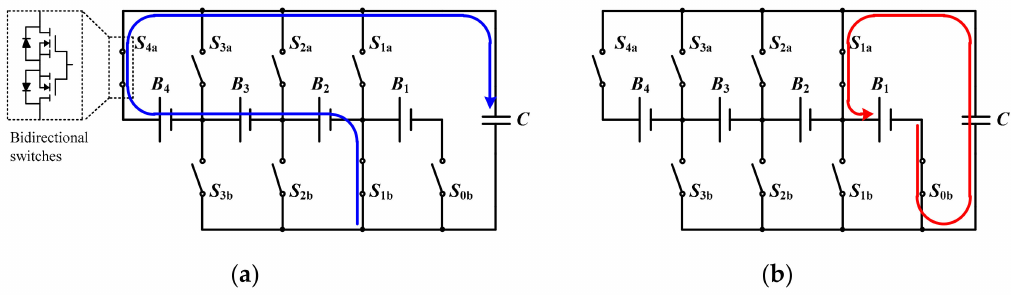
Figure 3. Switching states of a MC2MC equalizer based on SCC. ( a ) Collect state. ( b ) Release state.